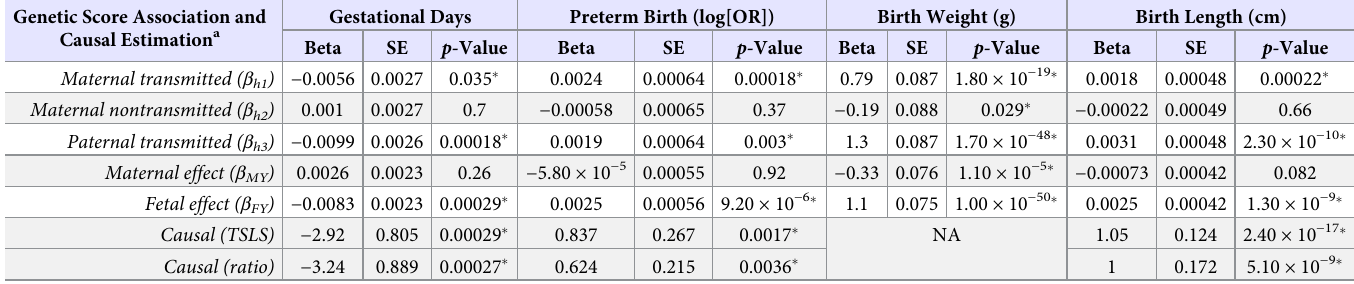
Table 3. Associations between birth weight genetic scores and birth outcomes and estimated causal effects per 1-SD change in gestational-age–adjusted birth weight. Genetic Score Association and Causal Estimation a